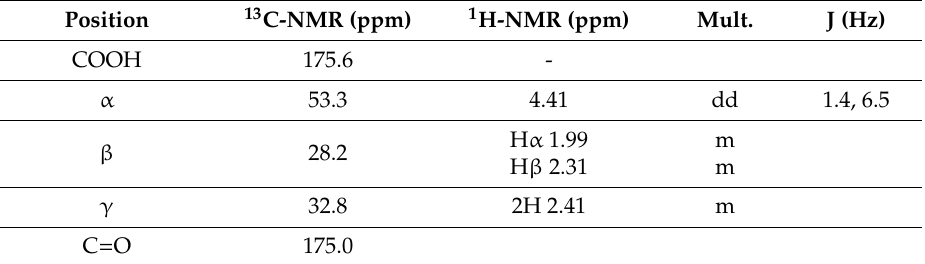
Table 4. 1 H-NMR (800 MHz) and 13 C-NMR (200 MHz) for cnidarin 4C ( 3 ) in CD 3 OD. Position 13 C-NMR